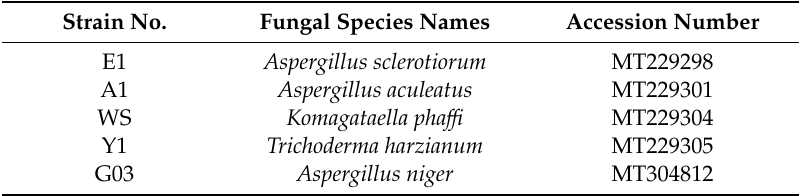
Table 2. Accession numbers of the